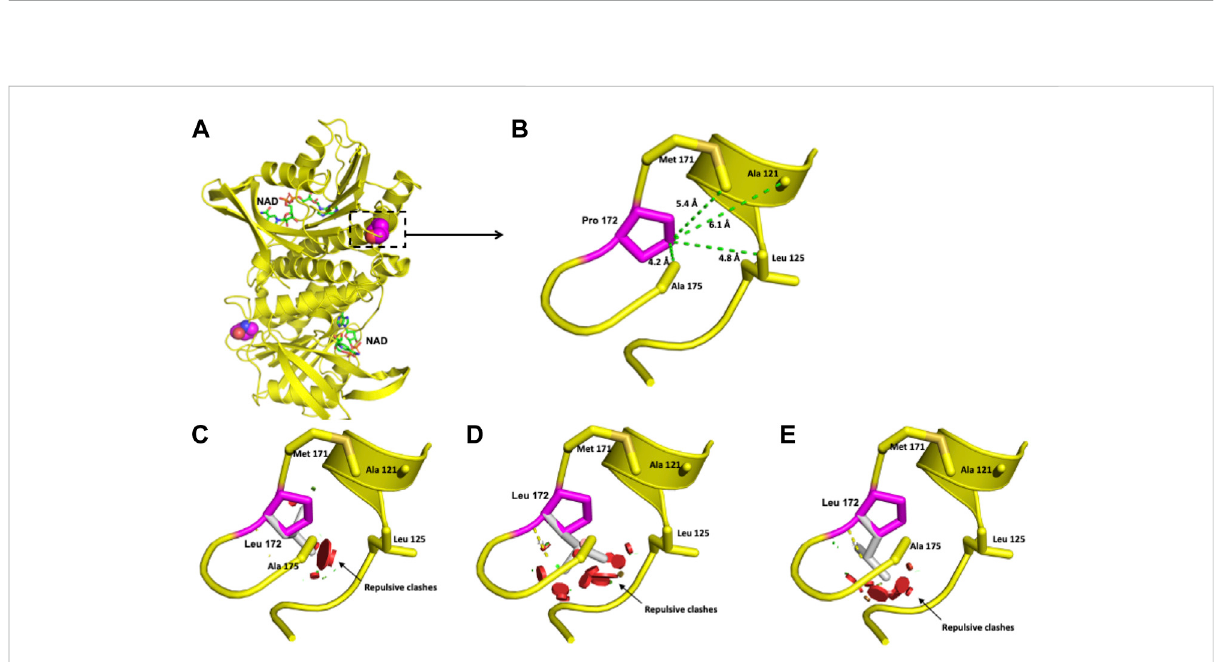
FIGURE 4 Modeling of the human DHPR structure with p.(Pro172Leu) change. (A) Crystallographic structure of a dimer of DHPR and location of the Pro 172residuesoneachmonomer. (B) LocationofthePro172residueinonemonomer. (C – E) Potentialdisturbingstructuraleffectsforthesubstitution of Pro 172 by